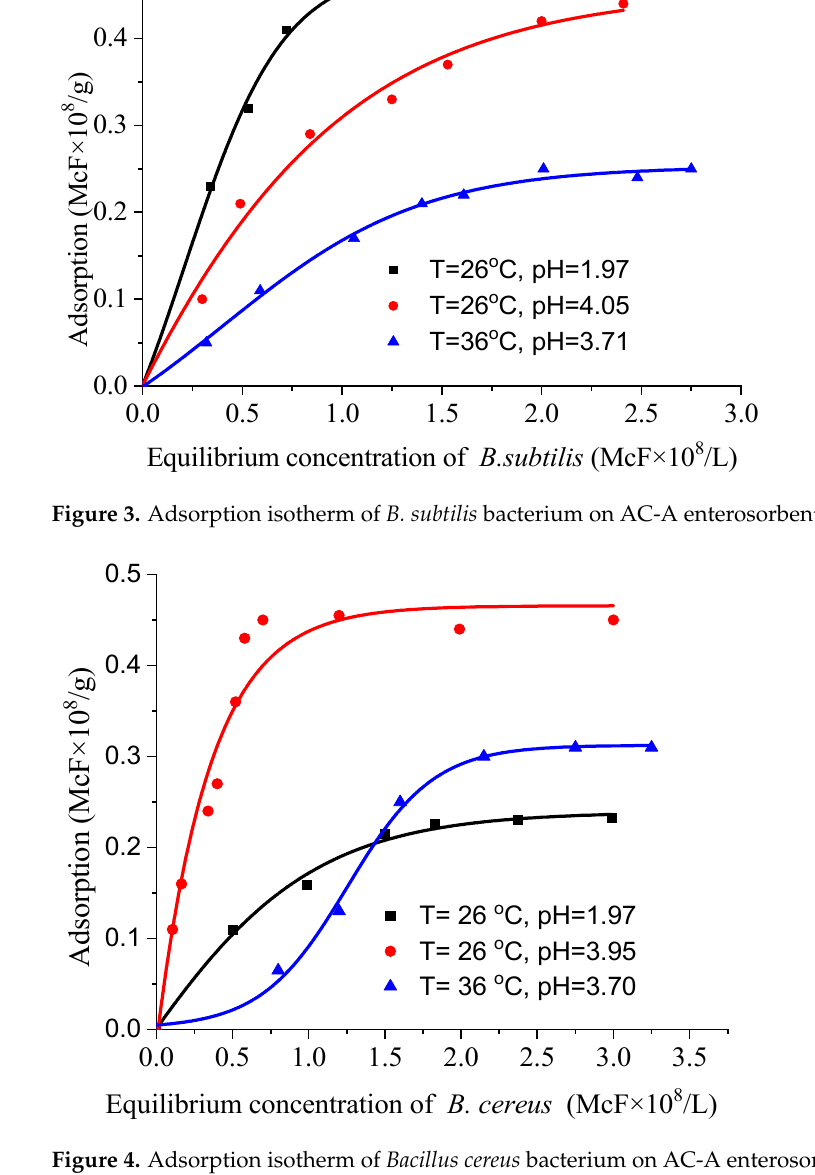
Figure 4. Adsorption isotherm of Bacillus cereus bacterium on AC-A enterosorbent. Table 3. Langmuir and Freundlich isotherm constants and correlation coefficients of B. subtilis and B. cereus adsorption capacity on